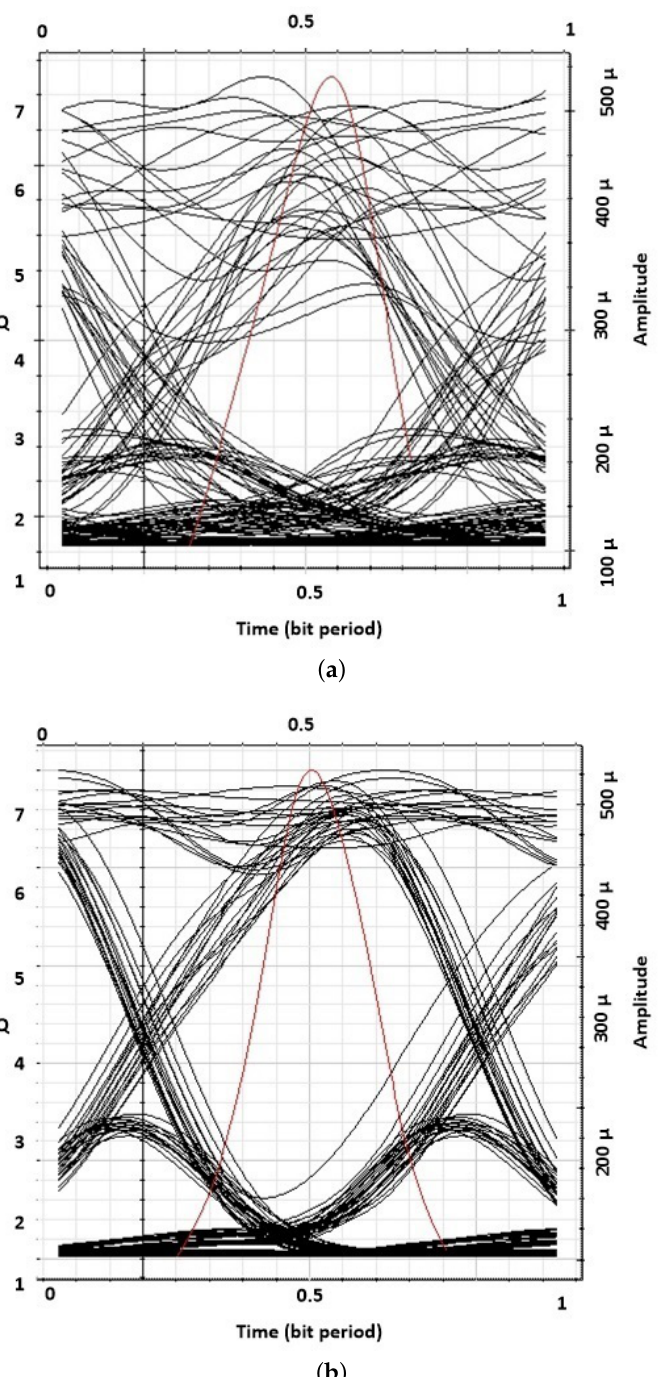
Figure 9. ( a ) Worse representation of eye diagram due to unsecure model. ( b ) Eye diagram of encrypted proposed